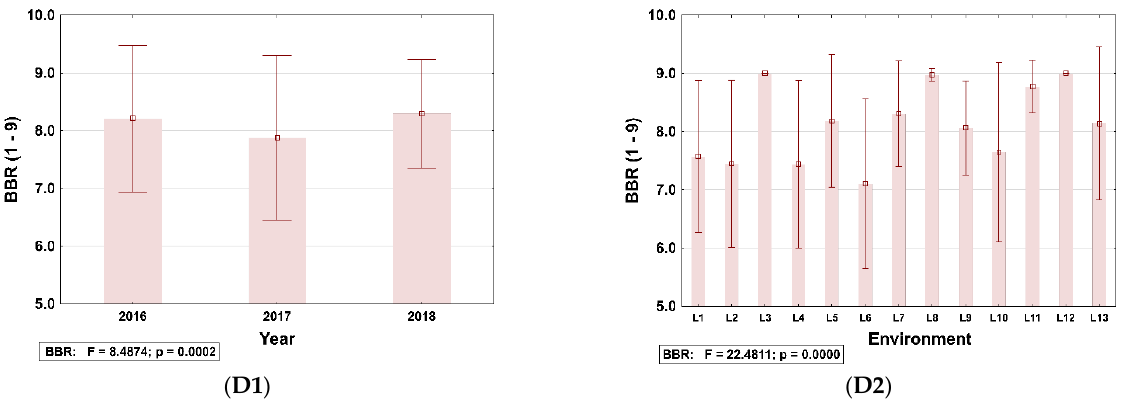
Figure 3. Averages for powdery mildew (PM), net blotch (NB), rhynchosporium (SB), and barley brown rust (BBR) levels of resistance of 20 varieties growing in thirteen environments (L1–L13) in 2016, 2017, and 2018. PM resistance: ( A1 ) presents averages in 2016, 2017, and 2018 based on the data collected for 20 varieties in thirteen environments and ( A2 ) present averages in thirteen environments based on the data collected for 20 varieties in 2016, 2017, and 2018. NB resistance: ( B1 ) presents averages of resistance in 2016, 2017, and 2018 based on the data collected for 20 varieties in thirteen environments and ( B2 ) presents averages of resistance in thirteen environments based on the data collected for 20 varieties in 2016, 2017, and 2018. SB resistance: ( C1 ) presents averages in 2016, 2017, and 2018 based on the data collected for 20 varieties in thirteen environments and ( C2 ) presents averages in thirteen environments based on the data collected for 20 varieties in 2016, 2017, and 2018. BBR resistance: ( D1 ) presents averages in 2016, 2017, and 2018 based on the data collected for 20 varieties in thirteen environments and ( D2 ) presents averages in thirteen environments based on the data collected for 20 varieties in 2016, 2017, and 2018. Analysis of variance (ANOVA test; α ≤ 0.05) values, which are presented under the figures, confirm the significant differences for average powdery mildew resistance between years and between environments ( A1 , A2 ), significant differences for average net blotch resistance ( B1 , B2 ), significant differences for average rhynchosporium resistance ( C1 , C2 ), and significant differences for average barley brown rust resistance ( D1 , D2 ). Disease severity scored on 1–9 scale (9—no symptoms of the disease).